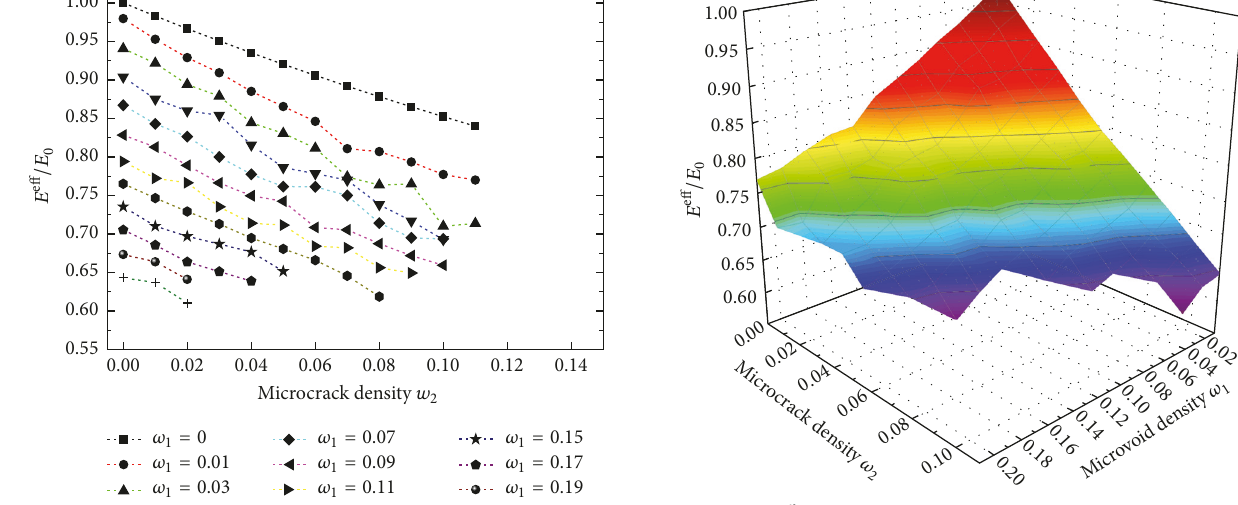
Figure 11: 𝐸 eff /𝐸 0 versus the microcrack’s and microvoid’s